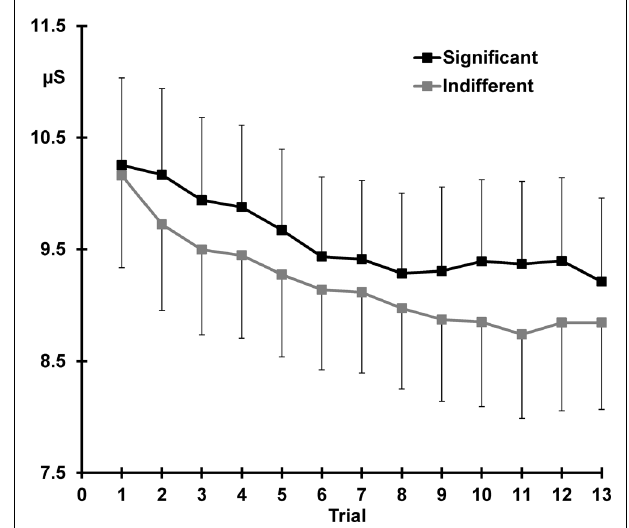
FIGURE 4 | Mean pre-stimulus SCL for each trial, again with standard error bars, separately for the two conditions. Response decrement is apparent over the first 10 trials and sensitization can be seen after presentation of the deviant (trial 11) at trial 12.